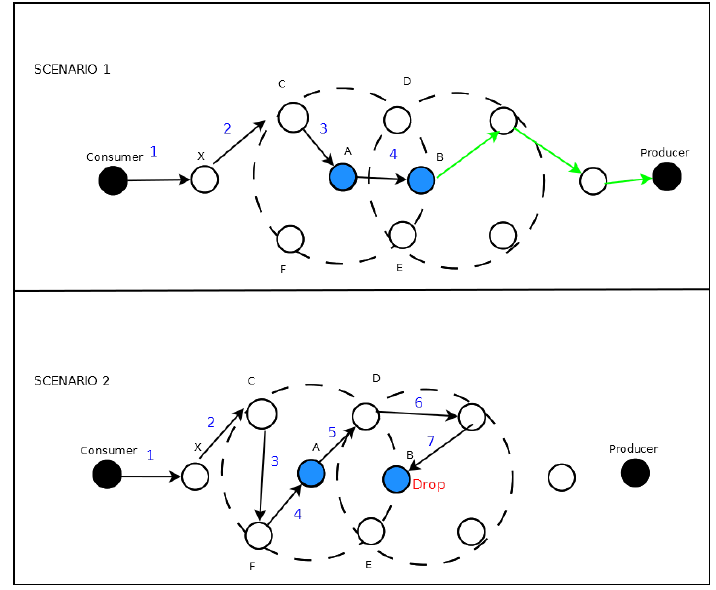
Figure 3. An example of ReCIF-soft in